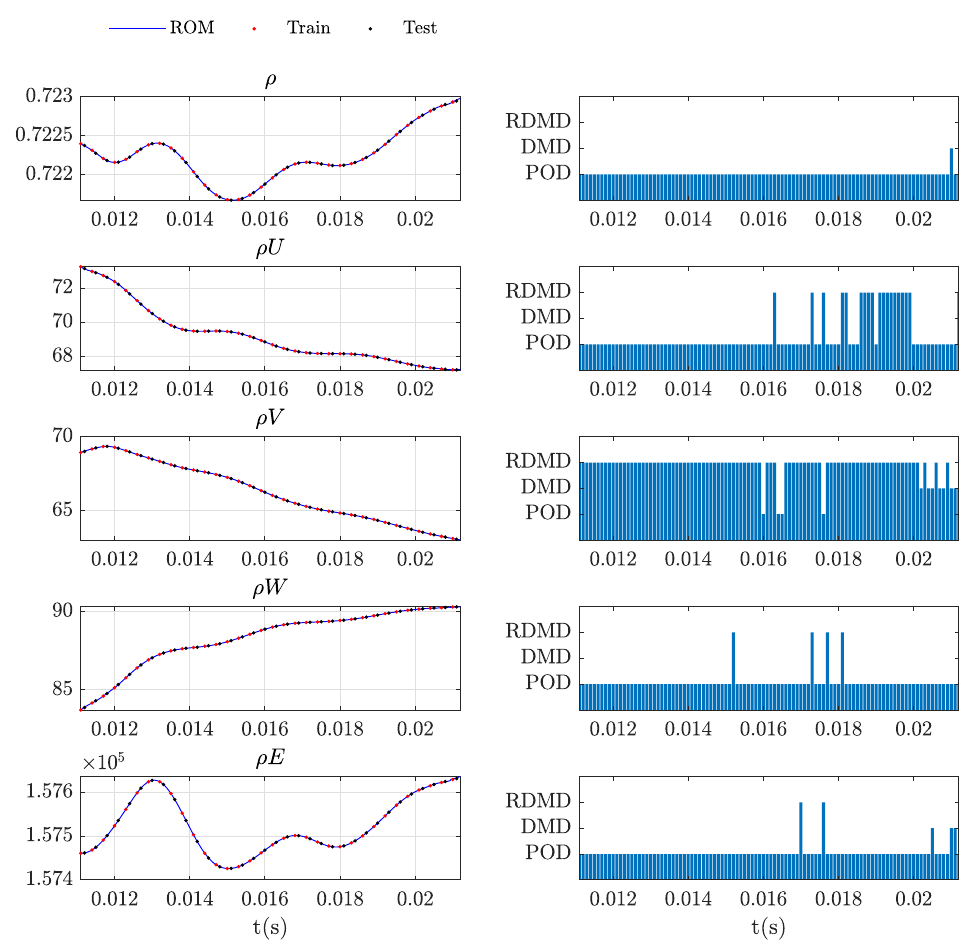
Figure 18. Evolution of the conserved quantities ( left column) and methods selected by the adaptive framework ( right column), within the time window investigated for the vortex breakdown in the delta wing test case. The continuous line represents the ROM; the red points are the training snapshots; the black points are the test points.